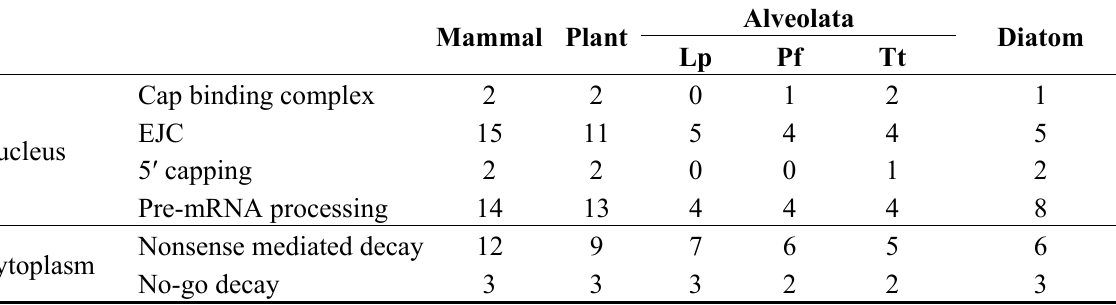
Table 2. Number of components involved in mRNA surveillance found in the L. polyedrum transcriptome . Gene sequences for various KEGG pathways were tabulated. The alveolates are represented by L. polyedrum (Lp), Plasmodium falciparum (Pf) and Tetrahymena thermophila (Tt). A cutoff value of e − 25 was used to assess the presence of